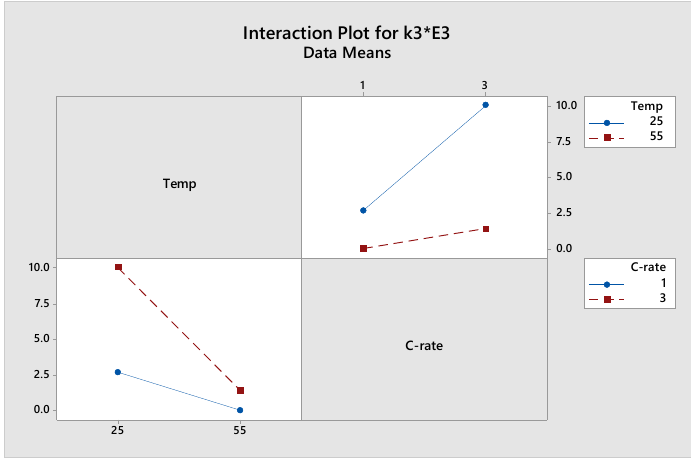
Figure 10. Interaction of current density and temperature in the k 3 value.